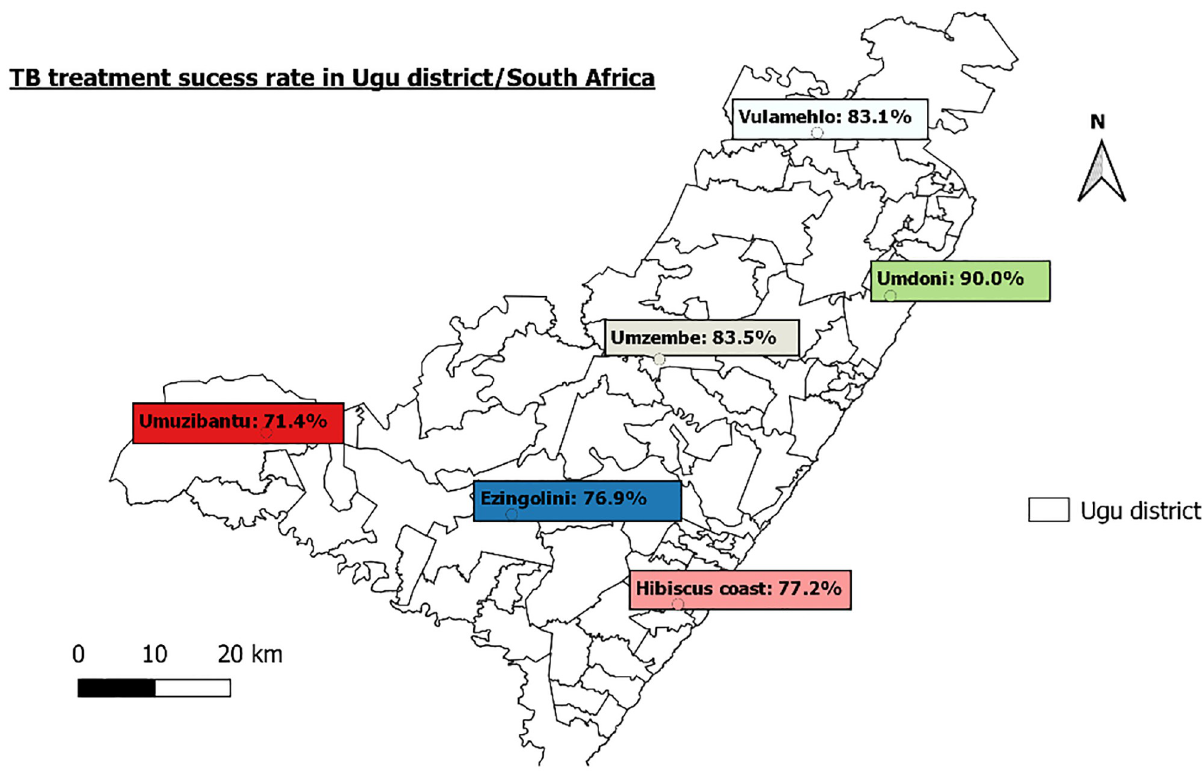
Fig 2. TB treatment success rate in Ugu district/South